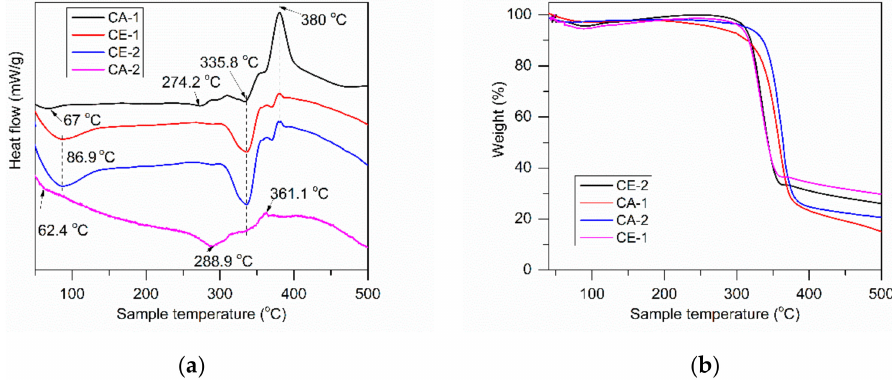
Figure 5. Curves of ( a ) Di ff erential Scanning Calorimetry (DSC) and ( b ) Thermogravimetric Analysis (TGA) to CE-1, CE-2, CA-1, and